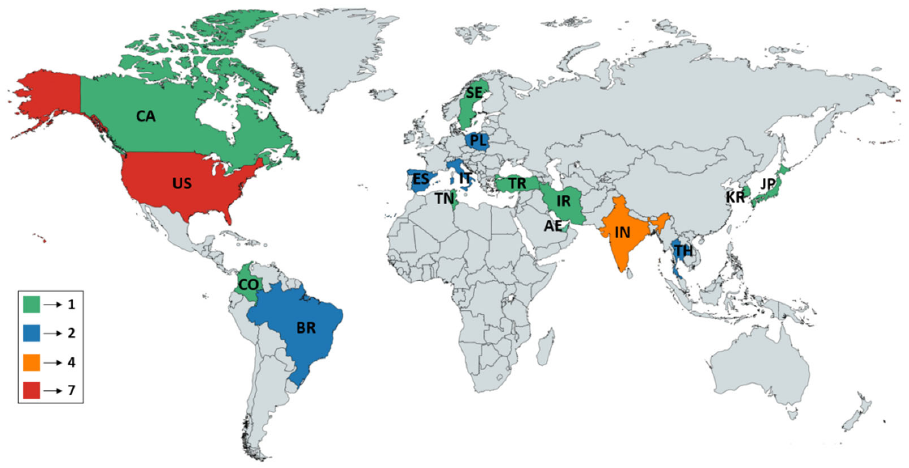
Figure 2. Geographical distribution of all contributing research organizations worldwide.